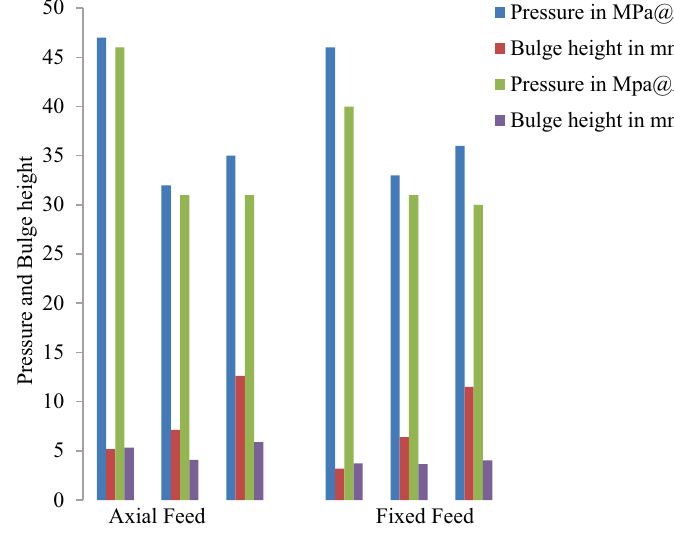
Table 8 Comparative analysis Ref.